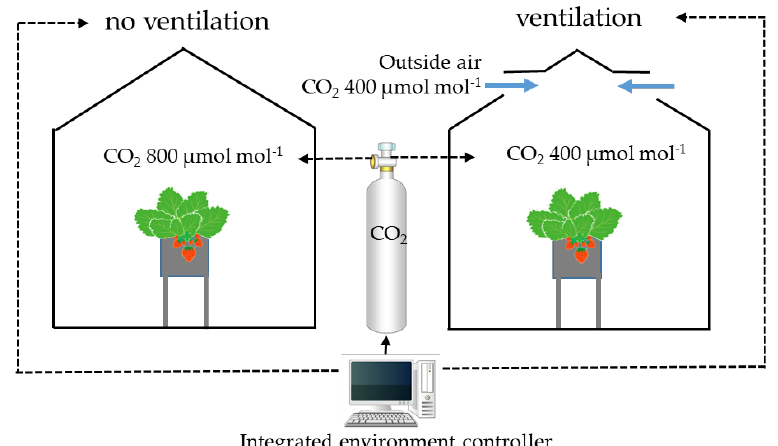
Figure 1. A schematic illustration of 800 μmol mol −1 treatment where the CO 2 concentration was kept above 800 μmol mol −1 during no ventilation and 400 μmol mol −1 during ventilation.